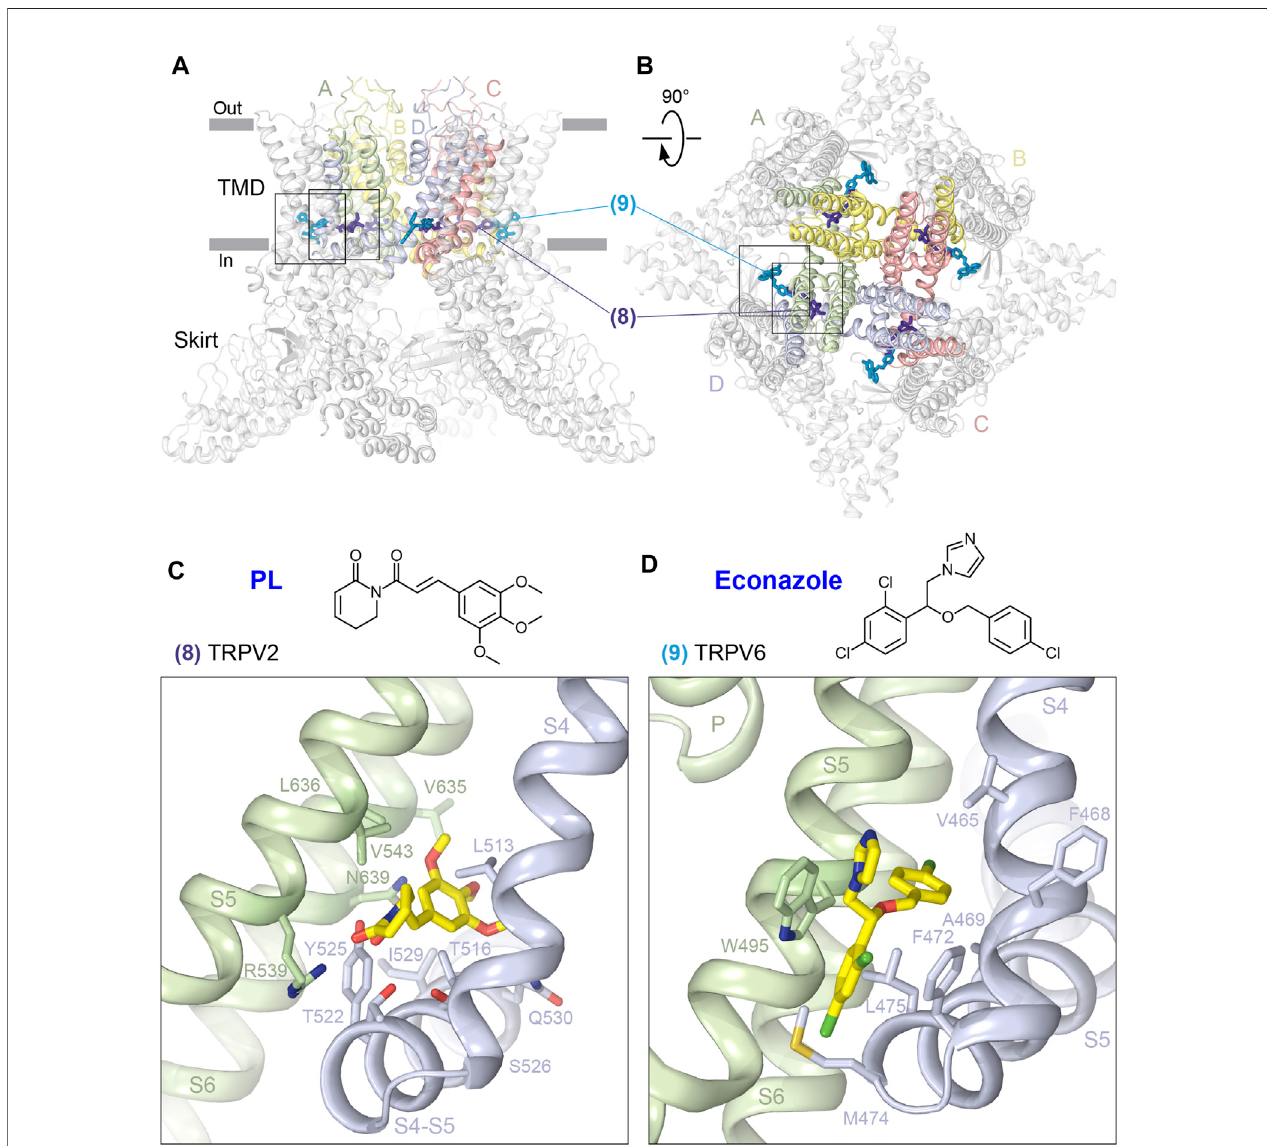
FIGURE 4 | S4-S5 sites. (A – B) Side (A) and top (B) views of the TRPV1 tetramer (gray; PDB ID: 7LQY) with the S4-S5 deep (8) and shallow (9) sites illustrated by ligands in dark and light blue, respectively. Rectangles indicate the regions expanded in close-up views. (C-D) Close-up views of the deep S4-S5 site in TRPV2 with bound piperlongumine (C) (PDB ID: 6WKN) and shallow S4-S5 site in TRPV6 with bound econazole (D) (PDB ID: 7S8C). Residues contributing to ligand binding are shown in sticks. The chemical structures of the ligands are shown above the close-up